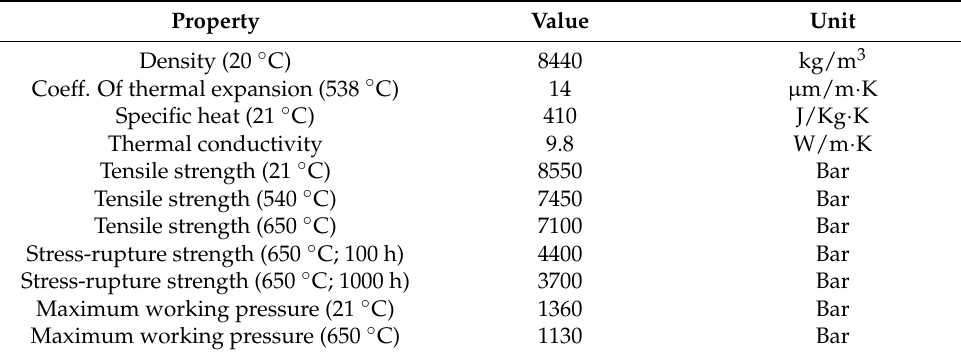
Figure 1. Reactor specifications. Adapted from HiP Company. Table 1. Physical properties of the reactor wall [40].